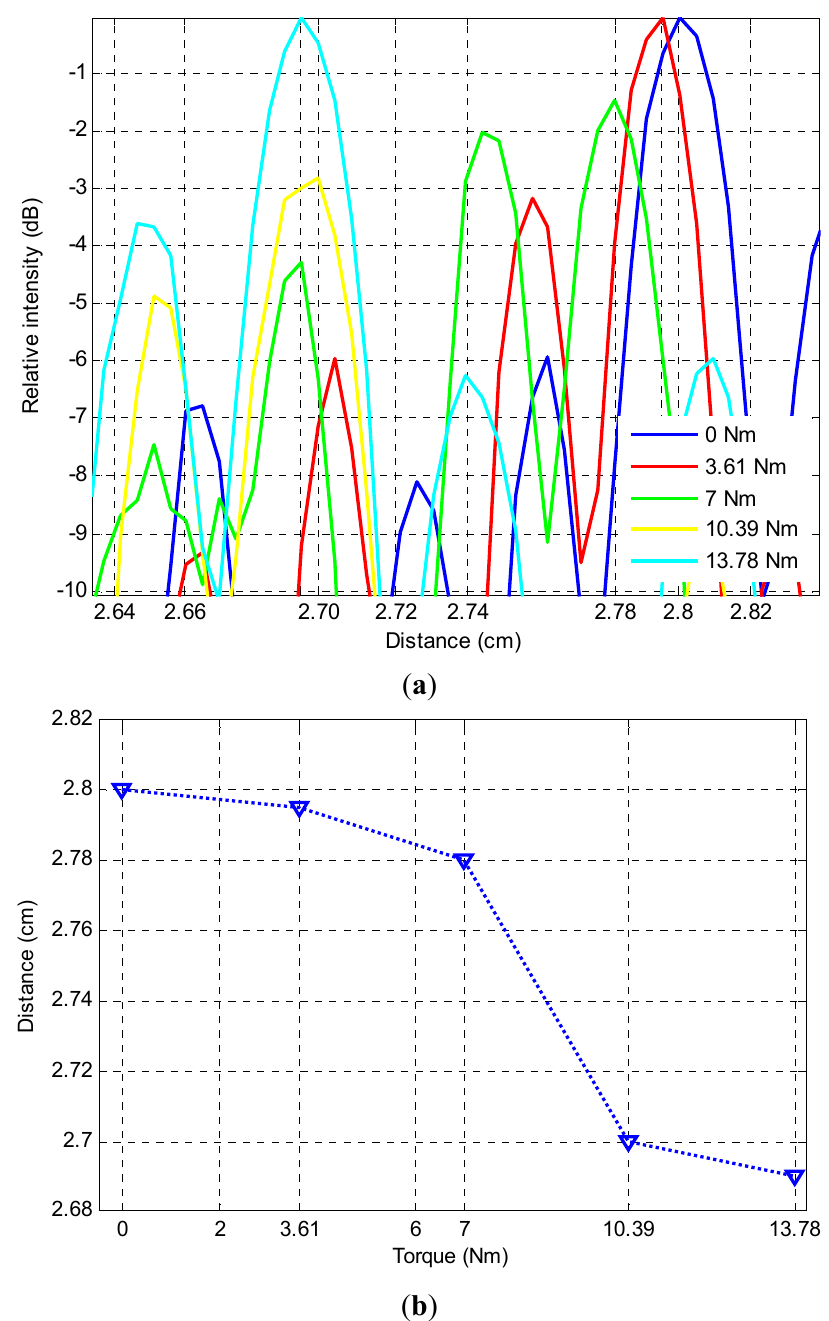
Figure 7. ( a ) Averaged 1-D images of the first reflection boundary with a dynamic range of 6 dB; ( b ) Experimentally obtained position of the first reflection boundary as a function of the torque